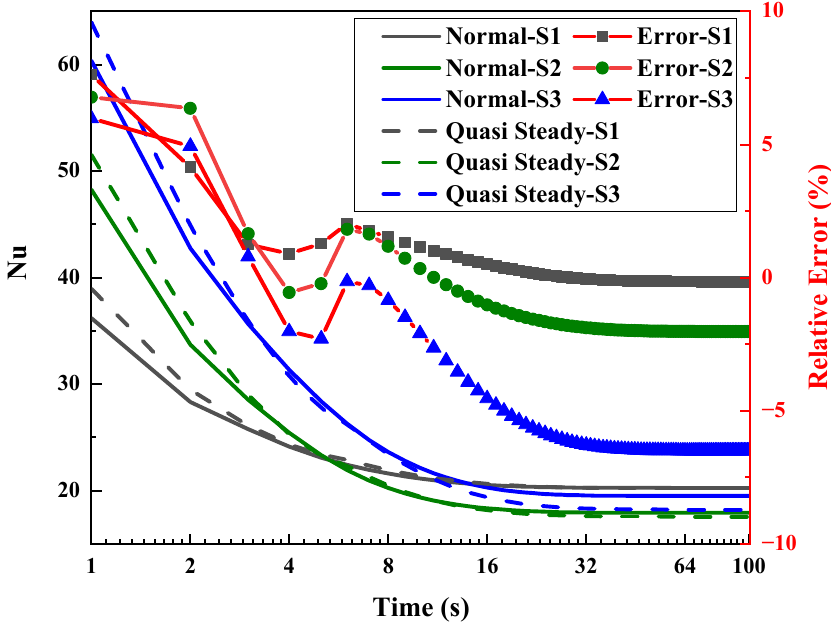
Figure 6. The average Nu variation curves of the three rectangular block surfaces with the quasi- steady and traditional coupling algorithms, and the error of the quasi-steady algorithm relative to the traditional coupling algorithm.